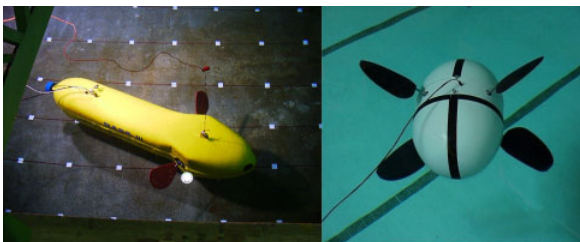
Figure 7 Biomimetic robots Bass3 (right) and PilotFish (left). Image of Bass3 was provided courtesy of N. Kato and image of PilotFish was courtesy of Nekton Research,